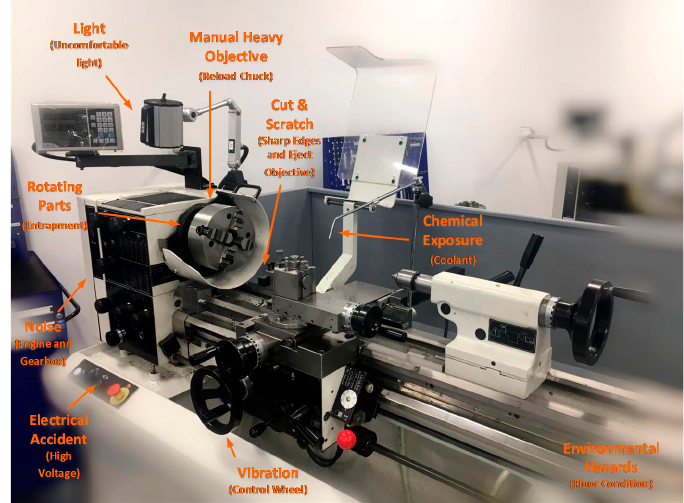
Figure 7. Lathe machine hazards.